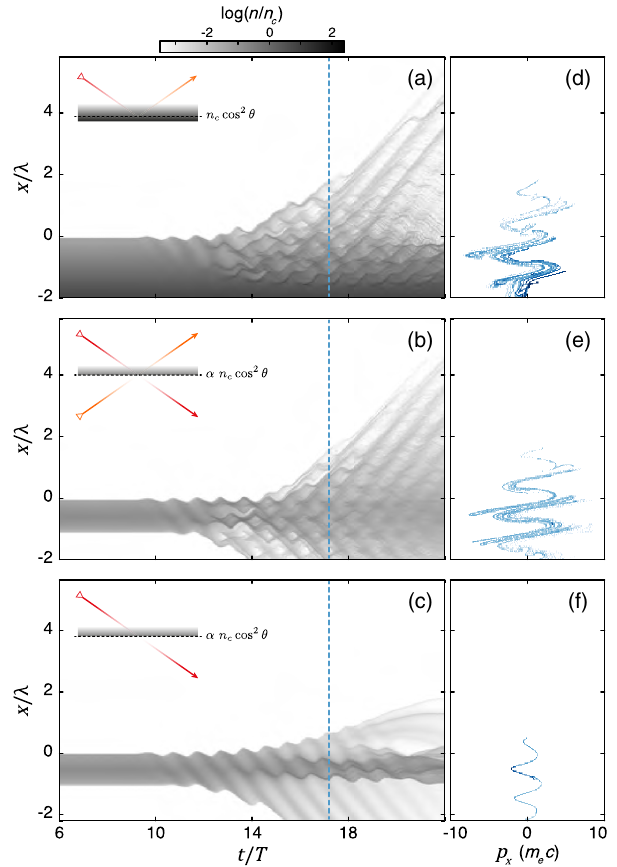
FIG. 8. Set of 2D plane wave PIC simulations carried out to reveal the role of the laser field reflected by the plasma. Each line corresponds to a different physical case [see insets in (a) – (c)]. Case A (upper line) corresponds to an overdense plasma with a density gradient of scale length L ¼ λ , irradiated by a single laser beam with an incidence angle θ i ¼ 55 ° and a 0 ¼ 2 . 5 . In case B, this plasma has been truncated for n > 0 . 4 n c cos 2 θ , keeping only the underdense part of the plasma, which is now irradiated by two almost identical laser beams (same parameters as in case A) arriving symmetrically from both sides of the plasma layer. In case C, this same plasma layer is irradiated only by the upper laser beam. In these three cases, plots of the temporal evolution of the plasma electron density [(a) – (c)] and snapshots of the x − p x phase space distribution of electrons [(d) – (f), taken at the time indicated by the blue line in (a) – (c)] are displayed. The multilayered phase space distributions of (d) and (e) strongly contrast with the smooth regular distribution of (f), and are typical of chaotic dynamics resulting from a repetitive stretching and folding effect in phase